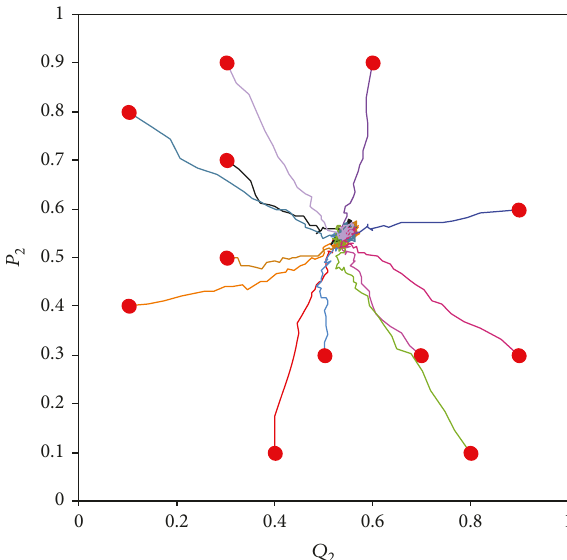
Q Figure 9: P 2 and 2 during the learning process of EAQR in Case 1 ( ε = 0 9 ).